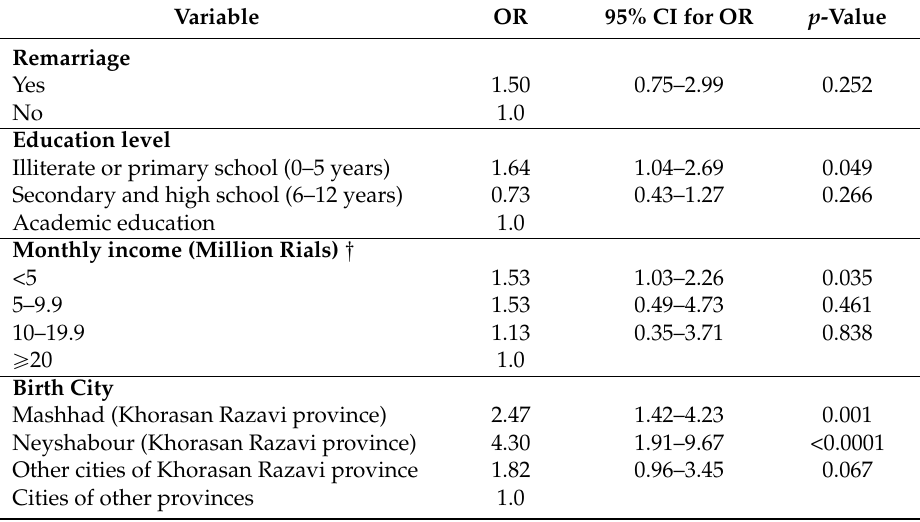
Table 5. Results from logistic regression analysis for HTLV-1 associated risk factors in blood